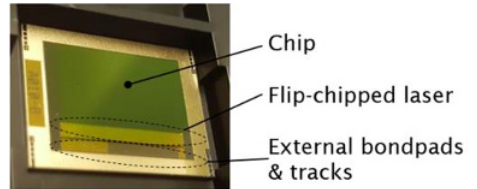
Fig. 1. Commercial laser integrated on SOI at Southampton 2 Flip-chip bonding